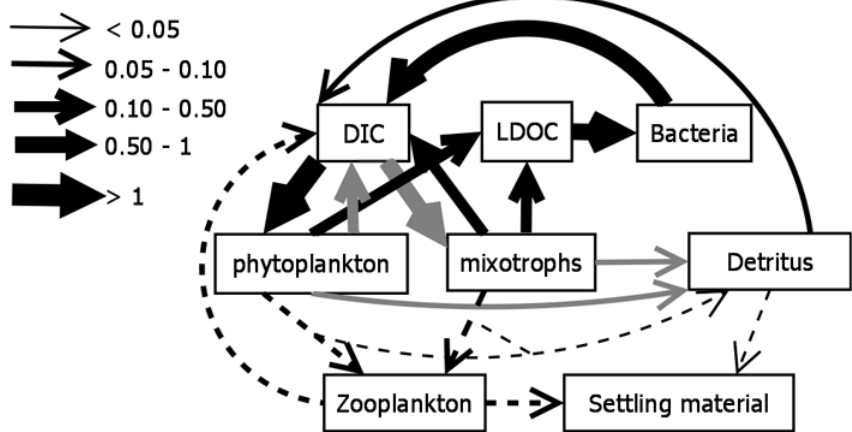
Fig. 7. Model-based carbon flow chart of phase 1 (before nutrient addition). The thicknesses of the arrows represent the size of the average carbon fluxes (µmolCL − 1 d − 1 ) between the major carbon pools. The dashed arrows indicate fluxes that were CO 2 sensitive (based on model). The grey arrows indicate fluxes that may depend on p CO 2 based on data analyses (Fig.